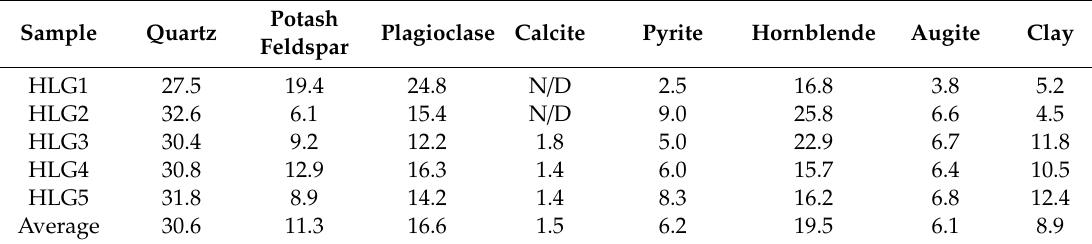
Table 1. The mineral composition (%) of glacial deposits at the Hailuogou